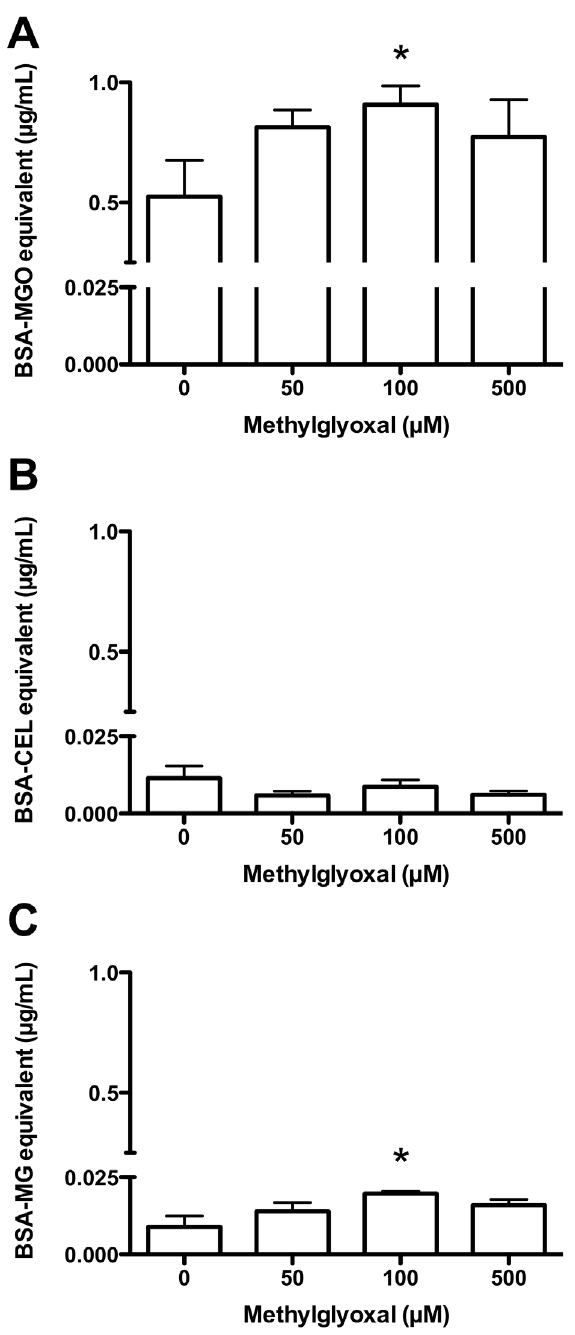
Figure 6. AGE formation on intact HCAEC following incubation with MGO. Intact HCAEC (3 6 10 5 cells/well; 2–3 wells per donor) were incubated with 0–500 m M MGO for 1 h in HBSS, with the formation of AGE determined by ELISA after cell lysis: (A) hydroimidazolones; (B) CEL, and; (C) CML. Data are means + SEM of AGE formation for 4 HCAEC donors, measured in duplicate ELISA wells. *Significant change in activity ( P , 0.05) compared to 0 mM control activity (one-way ANOVA with Tukey’s post-test).